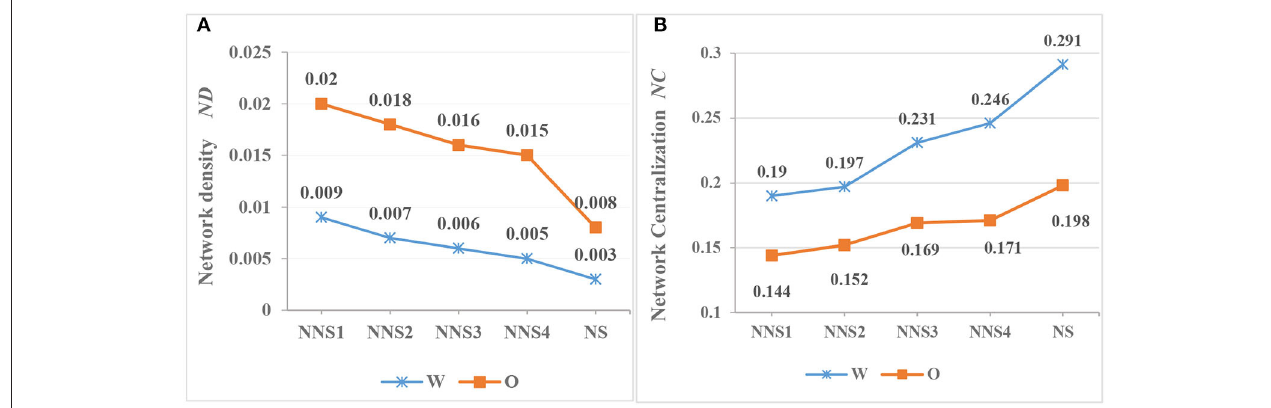
FIGURE 7 | This is a figure with sub figures, (A) shows the values of ND in CSL learners’ and native speakers’ syntax networks, the values of NC in CSL learners’ and native speakers’ syntax networks are shown in (B) .